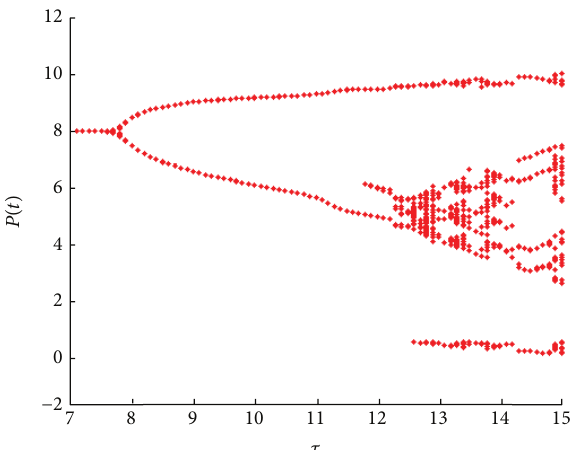
Figure 5: Bifurcation diagram for 𝜏 showing local maxima and minima of 𝑃(𝑡) for a given value of 𝜏 . Given the initial condition, for 𝜏 < 𝜏 0 the dynamics converges to the equilibrium 𝐹 2 = 8 . For 𝜏 = 𝜏 0 , the equilibrium undergoes a Hopf bifurcation and the dynamics are characterised by oscillations with a maximum and a minimum for 𝜏 ∈ (𝜏 0 ,𝜏 1 ) , with 𝜏 1 ≃ 11.6 . Just after 𝜏 1 it is possible to observe the birth of another local extremum. For 𝜏 = 𝜏 2 , a global bifurcation occurs and the dynamics lies in a larger portion of the phase plane. We note that for 𝜏 > 𝜏 2 there are several windows in which many maxima and minima coexist, so that fluctuations become more